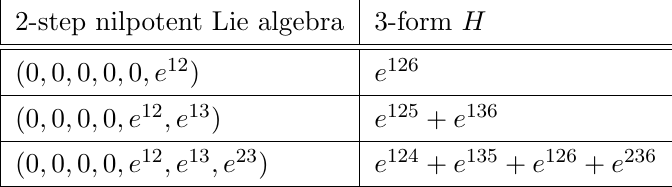
Table 2 . 6-dimensional 2-step nilpotent Lie algebra and the corresponding 3-form H .